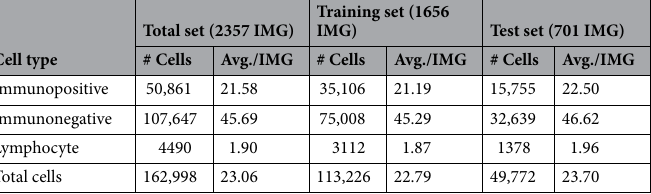
Table 2. Statistics of the annotated cells. The # cells reports the number of annotated cells. avg./IMG relate average cells per image.